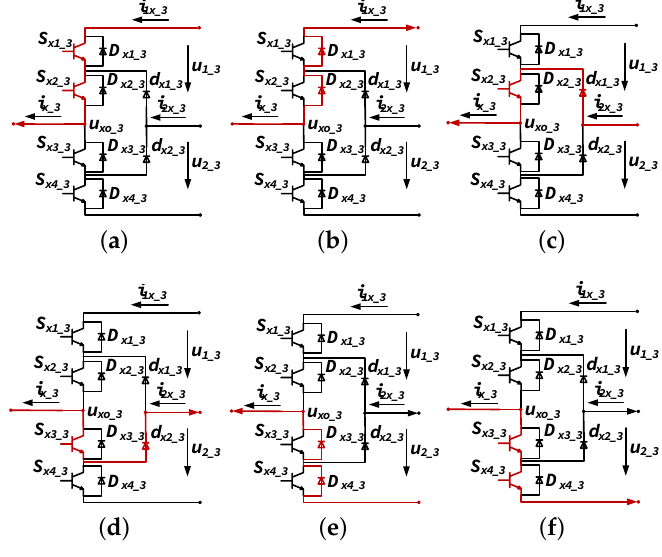
Figure 5. Current paths in a single three-level